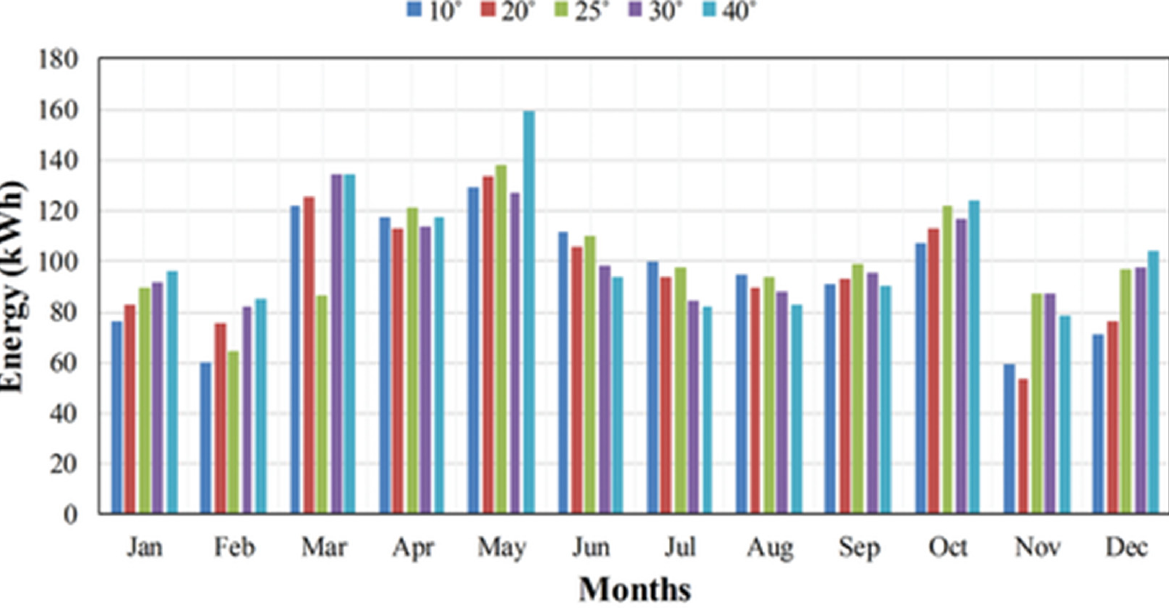
Figure 16. Output power of PV panels, at different tilt angles, on a monthly basis [102].